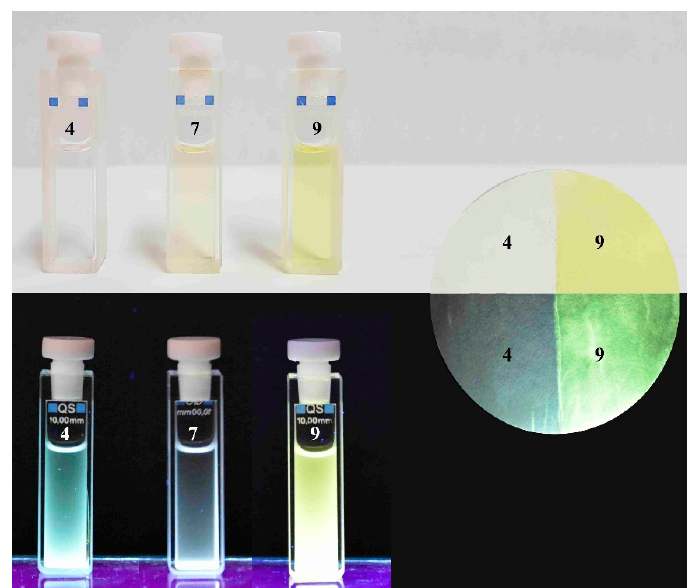
Figure 2. On the left: color of 100 μ M BTABr probe in buffer of pH = 4.0, pH = 7.0, and pH = 9.0 photographed under visible light ( above ) and UV lamp at 365 nm ( below ). On the right: color of laboratory paper soaked in the probe at pH = 4.0 (on the left ) and pH = 9.0 ( right ) photographed at visible light (above) and under UV lamp at 365 nm (down).